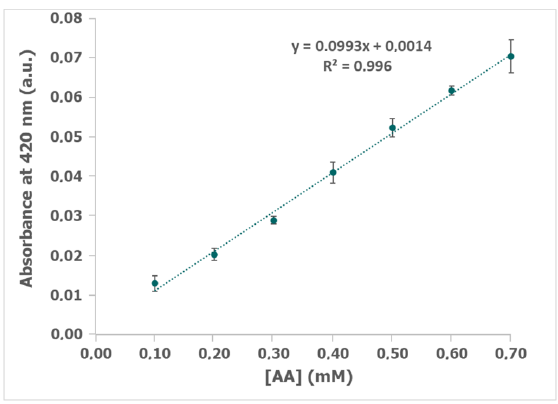
Figure 6. A calibration plot of absorbance at 420 nm obtained after applying +0.40 V for 300 s with different concentrations of acetaldehyde (AA) (0.1 – 0.7 mM) and 0.14 U/mL ALDH, 0.14 U/mL DP, 1 mM NAD + , 1 mM K 3 [Fe(CN) 6 ], and 0.1% BSA in 0.1 M phosphate and 0.1 M KCl buffer solution (pH 8).